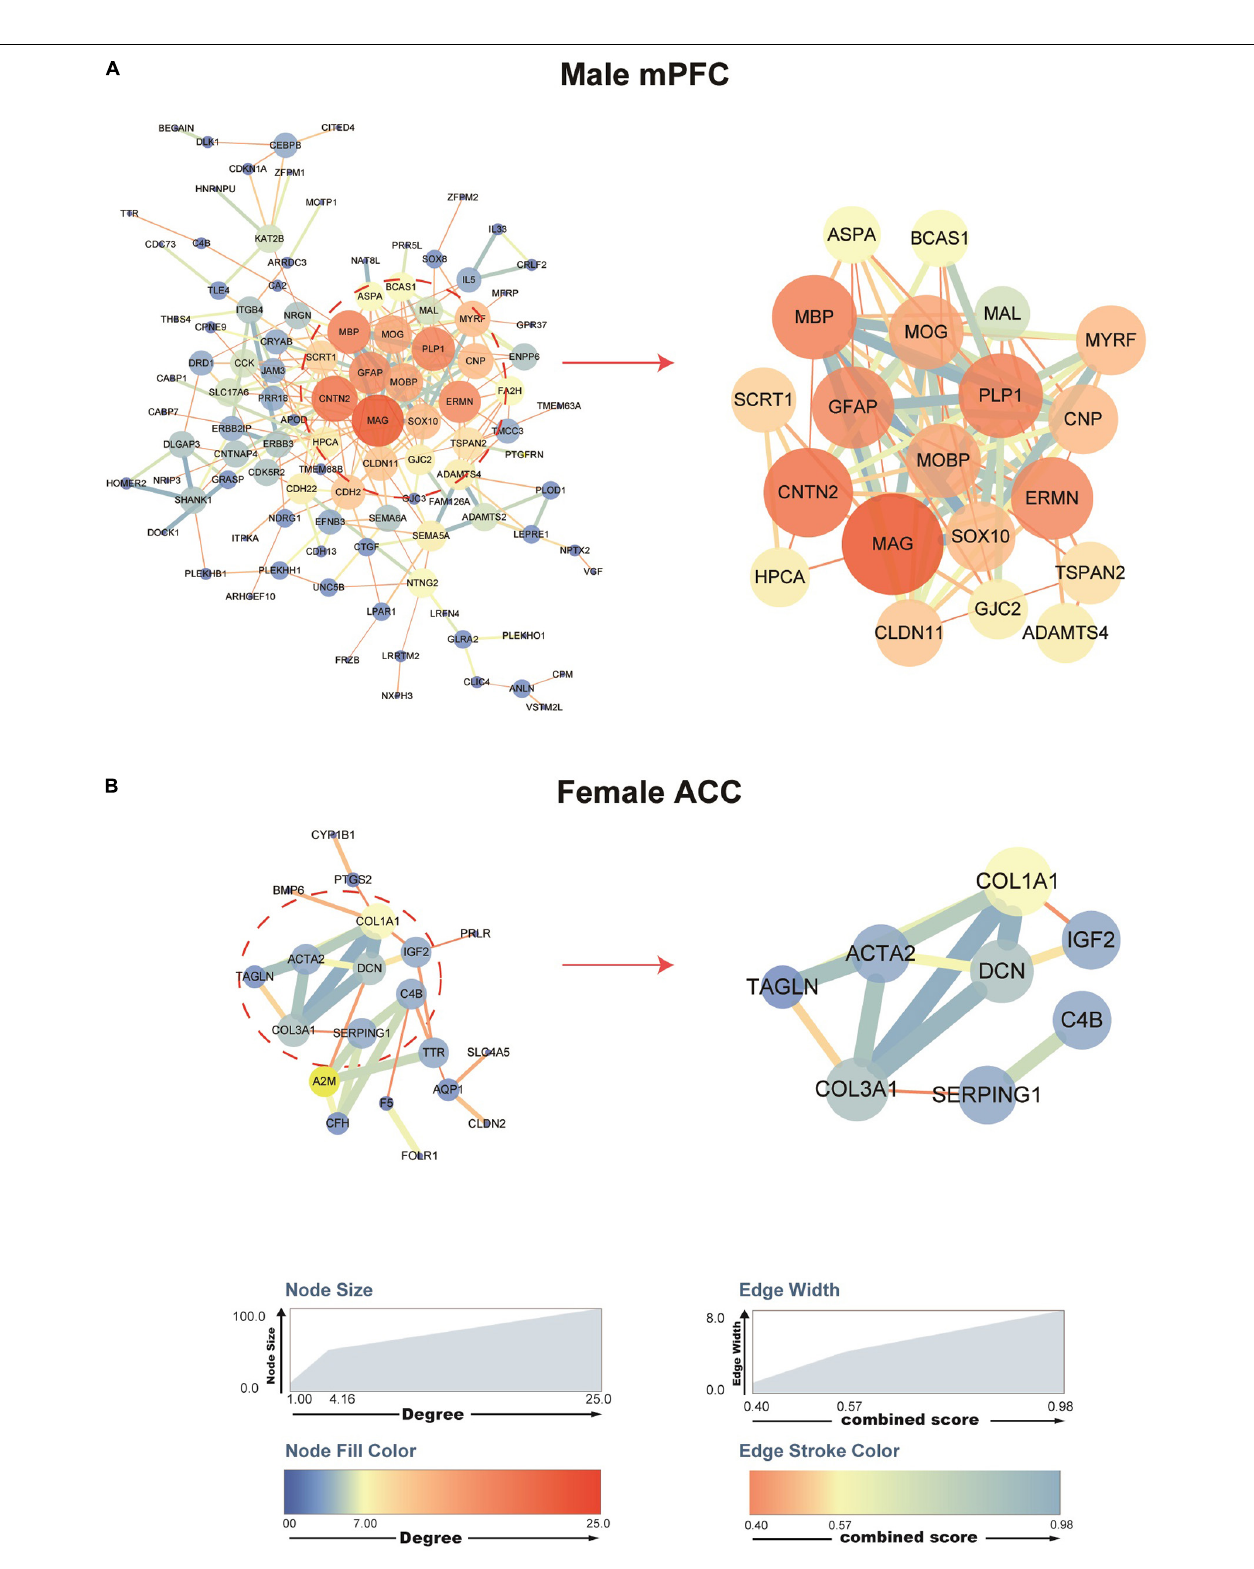
FIGURE 5 | Protein–protein interaction (PPI) networks of the DEGs in the male mPFC and female ACC, comparing the sham versus the SNI groups. STRING PPI networks depicting the potential interactions of the DEGs in the mPFC (A) and the ACC (B) at 2 weeks after SNI. The color and size of the nodes are relative to the degree of the connectivity, and the color and size of the edges are relative to the combined score of the interactions.